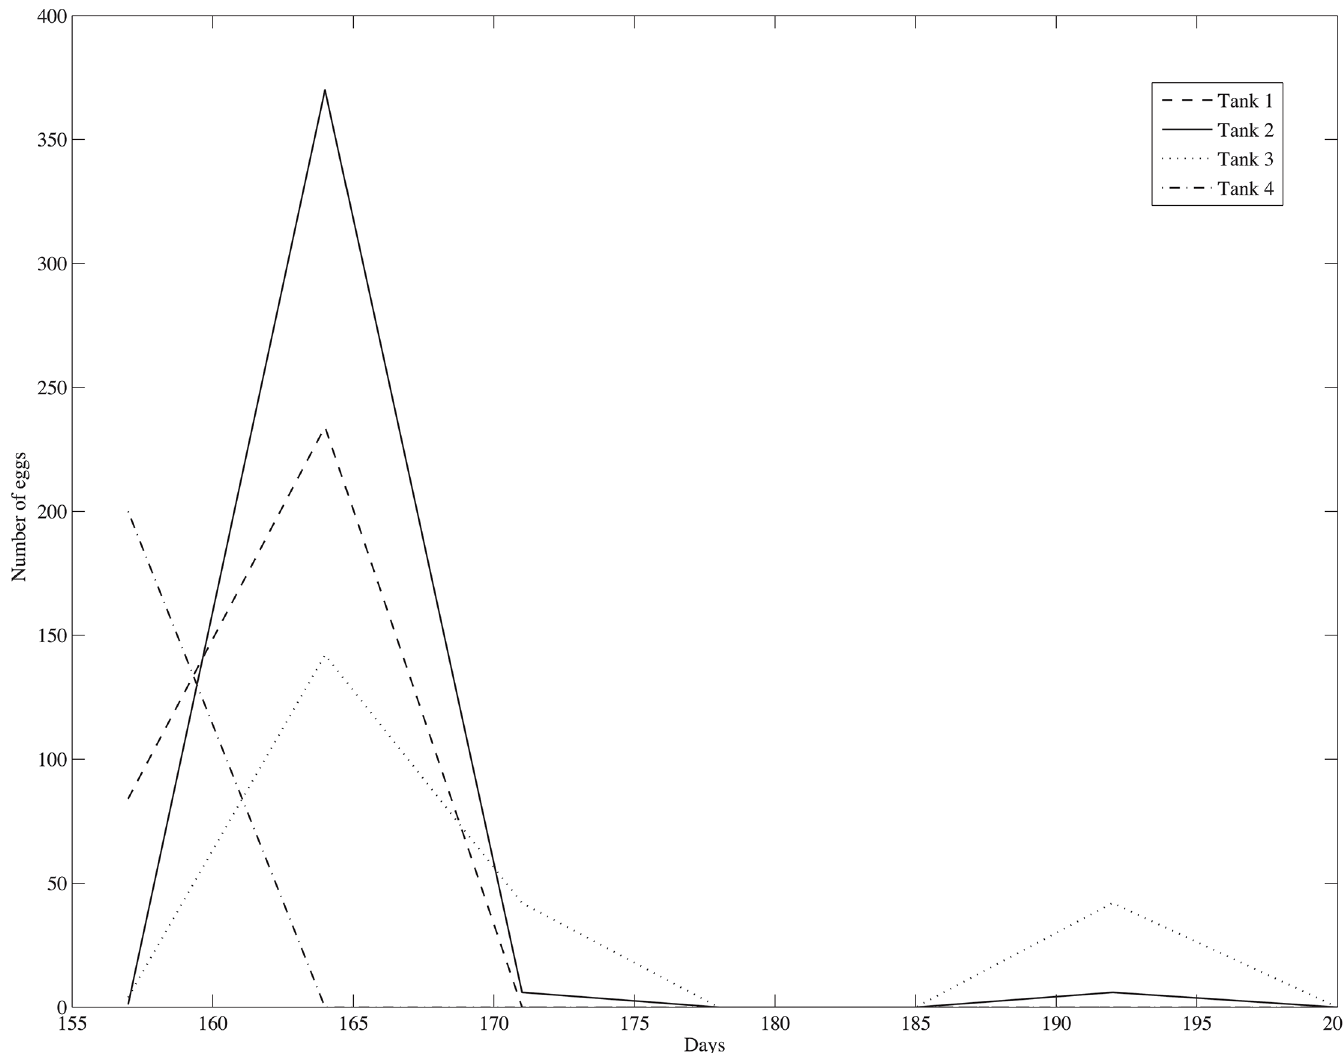
Fig 6. The egg production over time in the four replicates from day 150 to day